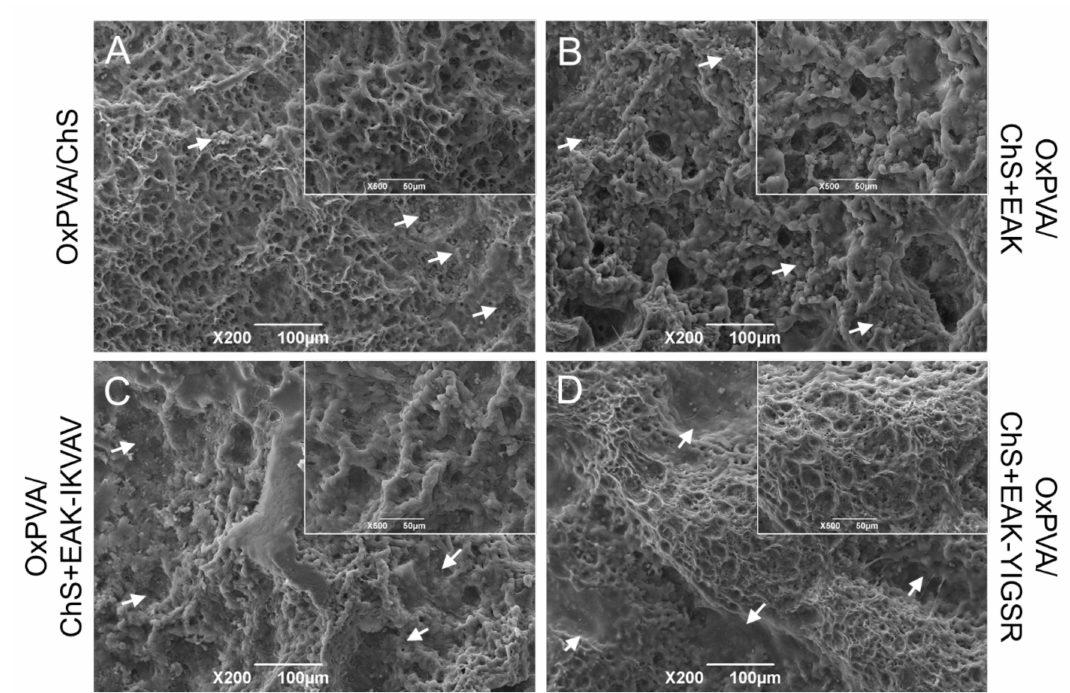
Figure 9. ( A – D ) SEM investigation of OxPVA/ChS-based scaffold surface ultrastructure after sub- cutaneous implantation into BALB/c mice for 14 days. Host cells were observed to adhere to the chitosan layers of all hybrid scaffolds (white arrows). Scale bar: 100 µ m. Higher magnification details for each group are shown in the inserts. Scale bar: 50 µ